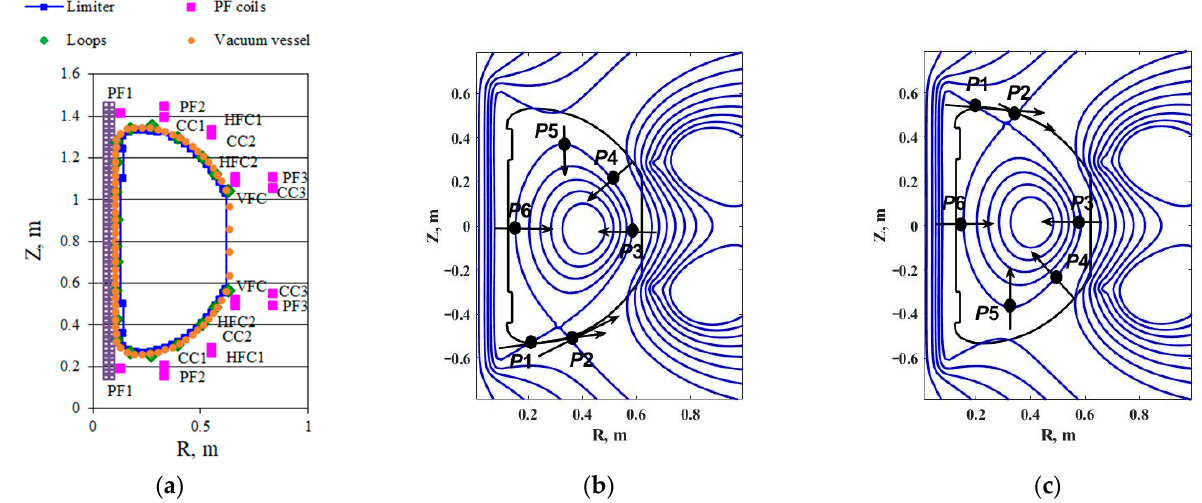
Figure 2. ( a ) Poloidal system; ( b ) equal level lines of poloidal magnetic flux in vertical cross-section of Globus-M/M2 and points P1–P6 for the gap control with a lower X-point and ( c ) upper X-point.